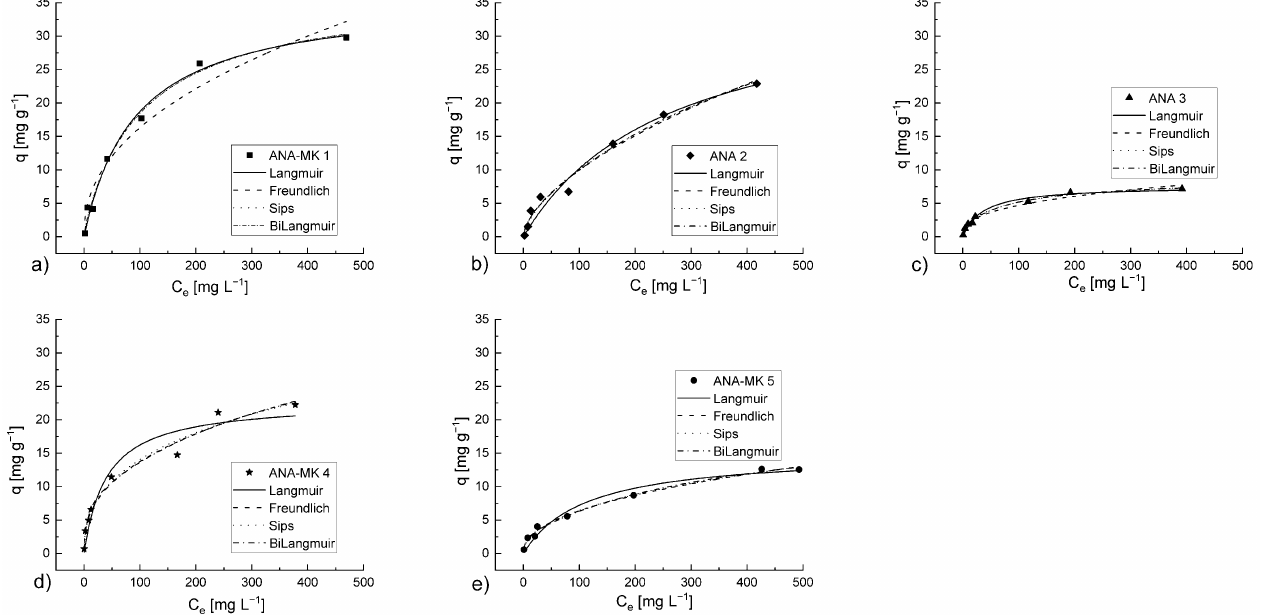
Figure 8. Isotherms for the sorption of NH 4+ ion onto ( a ) ANA-MK 1, ( b ) ANA 2, ( c ) ANA 3, ( d ) ANA-MK 4, and ( e ) ANA-MK 5. Experimental conditions: sorbent dosage: 5 g L −1 ; initial pH of the solution: 2.5; contact time: 24 h; and temperature: 22 °C – 23 °C. Analysis was based on the concentrations of NH 4+ -N. Table 6. Parameters for the sorption isotherms.